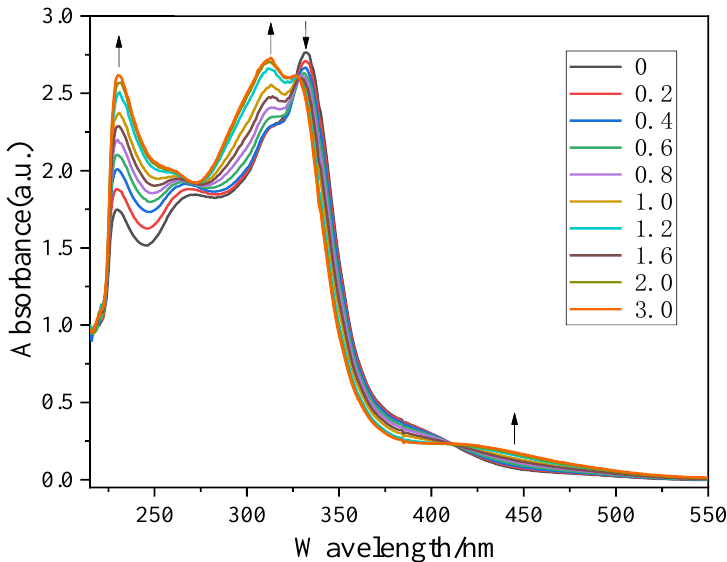
Figure 5. UV–vis titration spectra of 2 in CH 2 Cl 2 -MeOH (7:3, v / v ) in the presence of an increasing concentration of Ag + . [2] = 1 × 10 − 4 mol L − 1 ; 0–3 equiv of Ag + . The titration of Mg-NPc 1 against AgClO 4 is shown in Figure 6. Ag + binding showed marked effects on the macrocycle B and Q bands. Adding AgClO 4 initially caused a blue shift and sharpening of the Q band up to a metal/ 1 ratio of approximately 1:1, while the B bands showed a red shift and enhanced intensity (Figure 6). The addition of perchlorate cations other than silver perchlorate caused no change in the absorption spectra of 1 . Notably, no change in the absorption spectra was observed upon the addition of various other alkali metal ions, such as Li + , K + , and Cs + as shown in Figure S6, indicating the good complexation of 1 and 2 for Ag + . Meanwhile, the absorption spectra were checked upon the addition of soft transition metal ion Zn 2+ as described in Figure S7. The result demonstrated that no change was found. However, we did not check the 12-membered crown for encapsulation of Ag + . We think the cavity of the 12-membered crown is small if it could encapsulate Ag + ; it could form a sandwich compound.